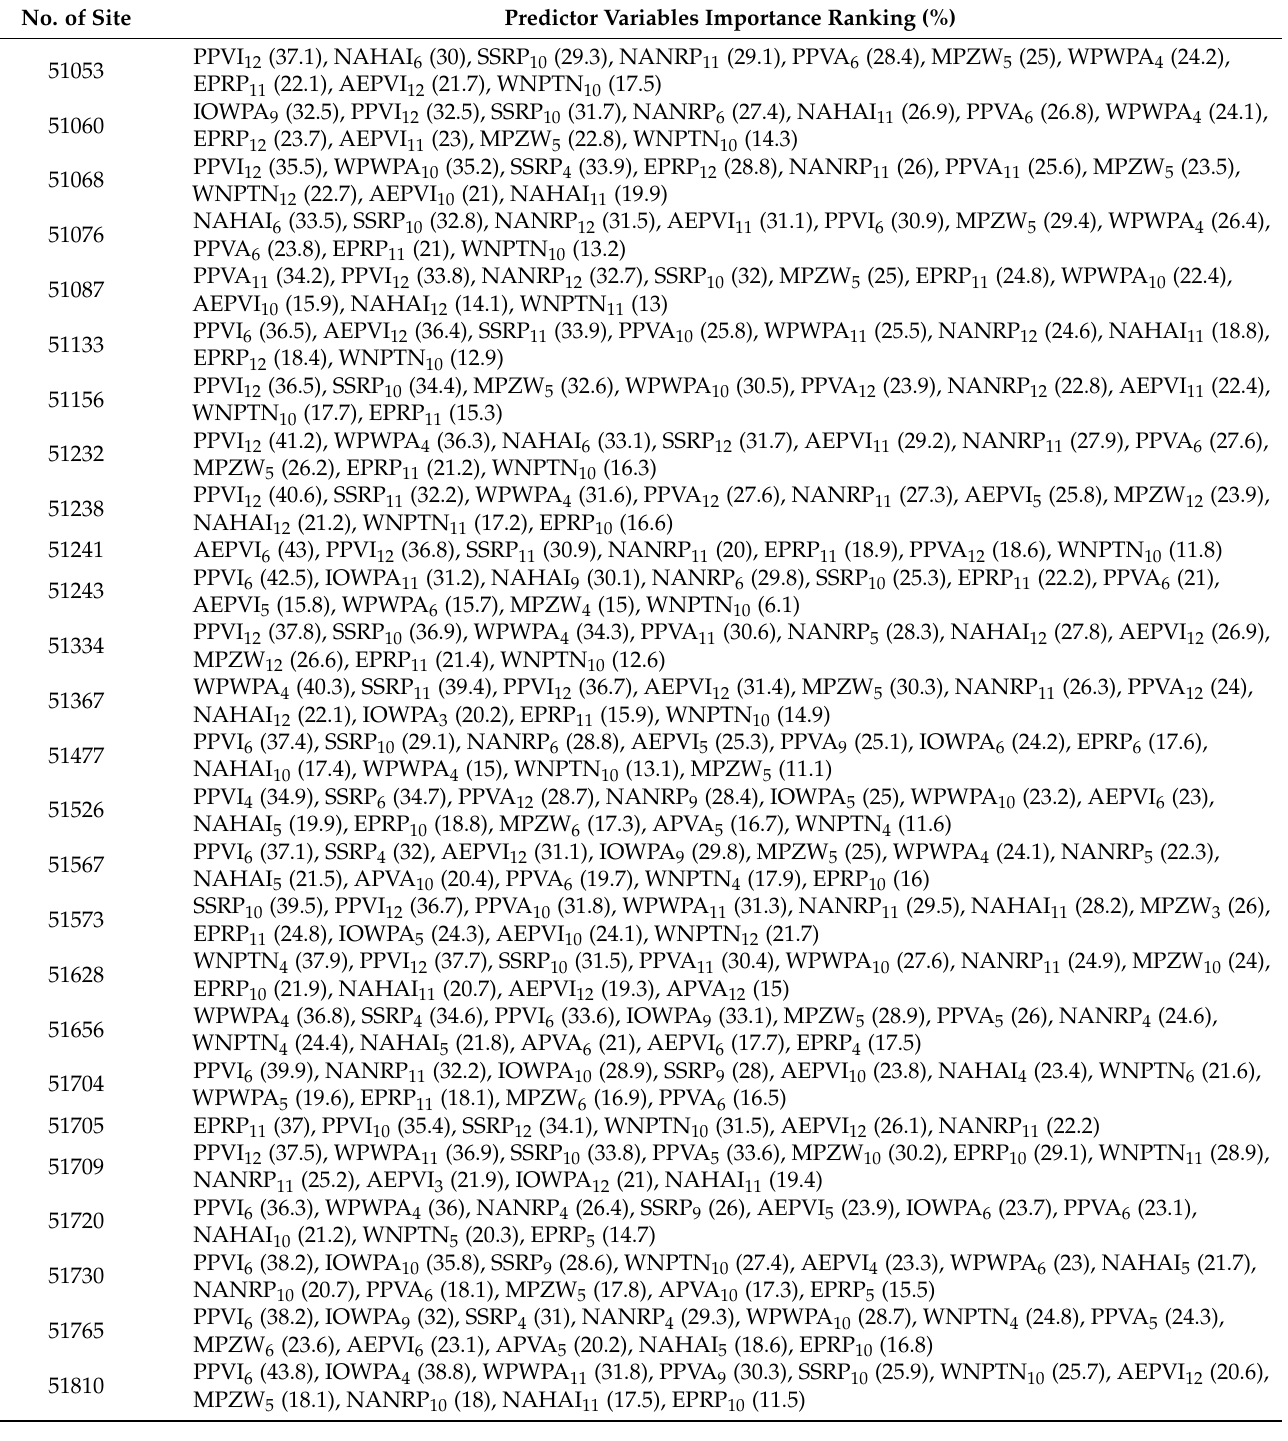
Table 3. The RF-based rank of the importance for the selected circulation indices at 44 sites in northwestern